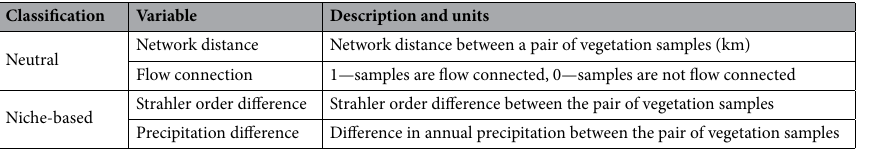
Table 1. List of neutral and niche-based variables included in the model developed to assess the relative importance of both neutral and niche-based factors for explaining changes in community similarity measured by Sorensen’s